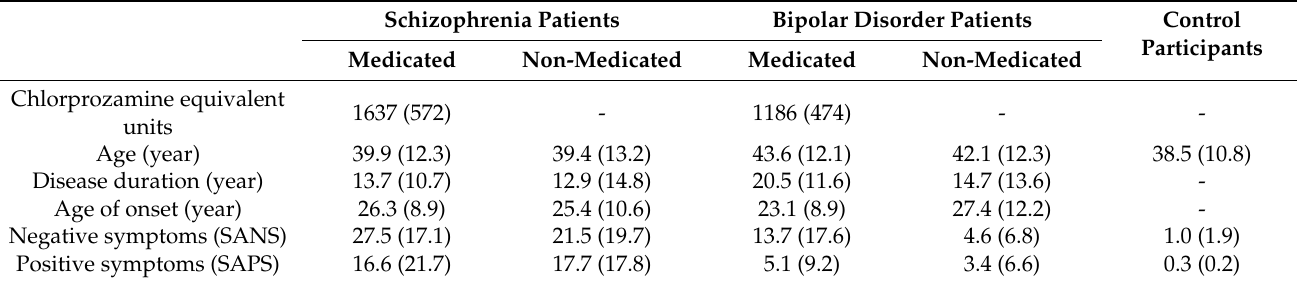
Table 1. Clinical, psychiatric, and neuropsychological profile of medicated (M) and non-medicated (NM) schizophrenic and bipolar patients, and control participants, as well as the current dosage of neuroleptic medication, expressed in chlorpromazine equivalent units (group means and standard deviation).